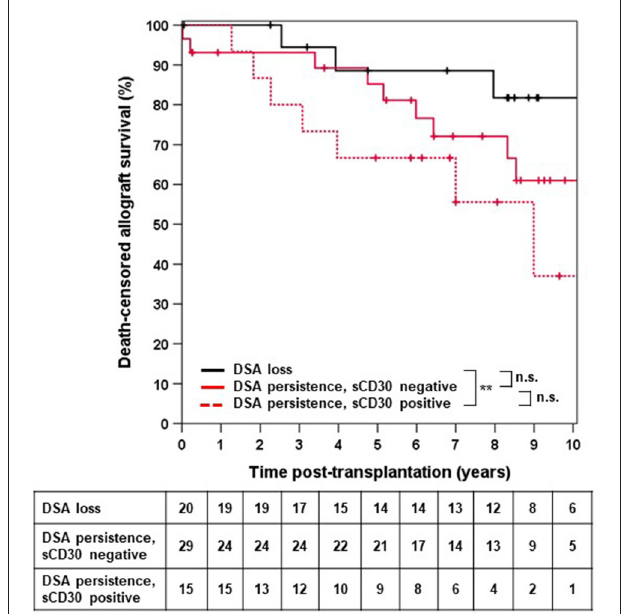
FIGURE 4 | Death-censored allograft survival in DSA-positive patients in whom no DSA were detectable 14 days post-transplant irrespective of sCD30 status (loss) or who were either sCD30-positive (sCD30 + ) or sCD30-negative (sCD30 − ) prior to transplantation and had persistence of DSA 14 days post-KTX. ** p = 0.008 and n.s. =